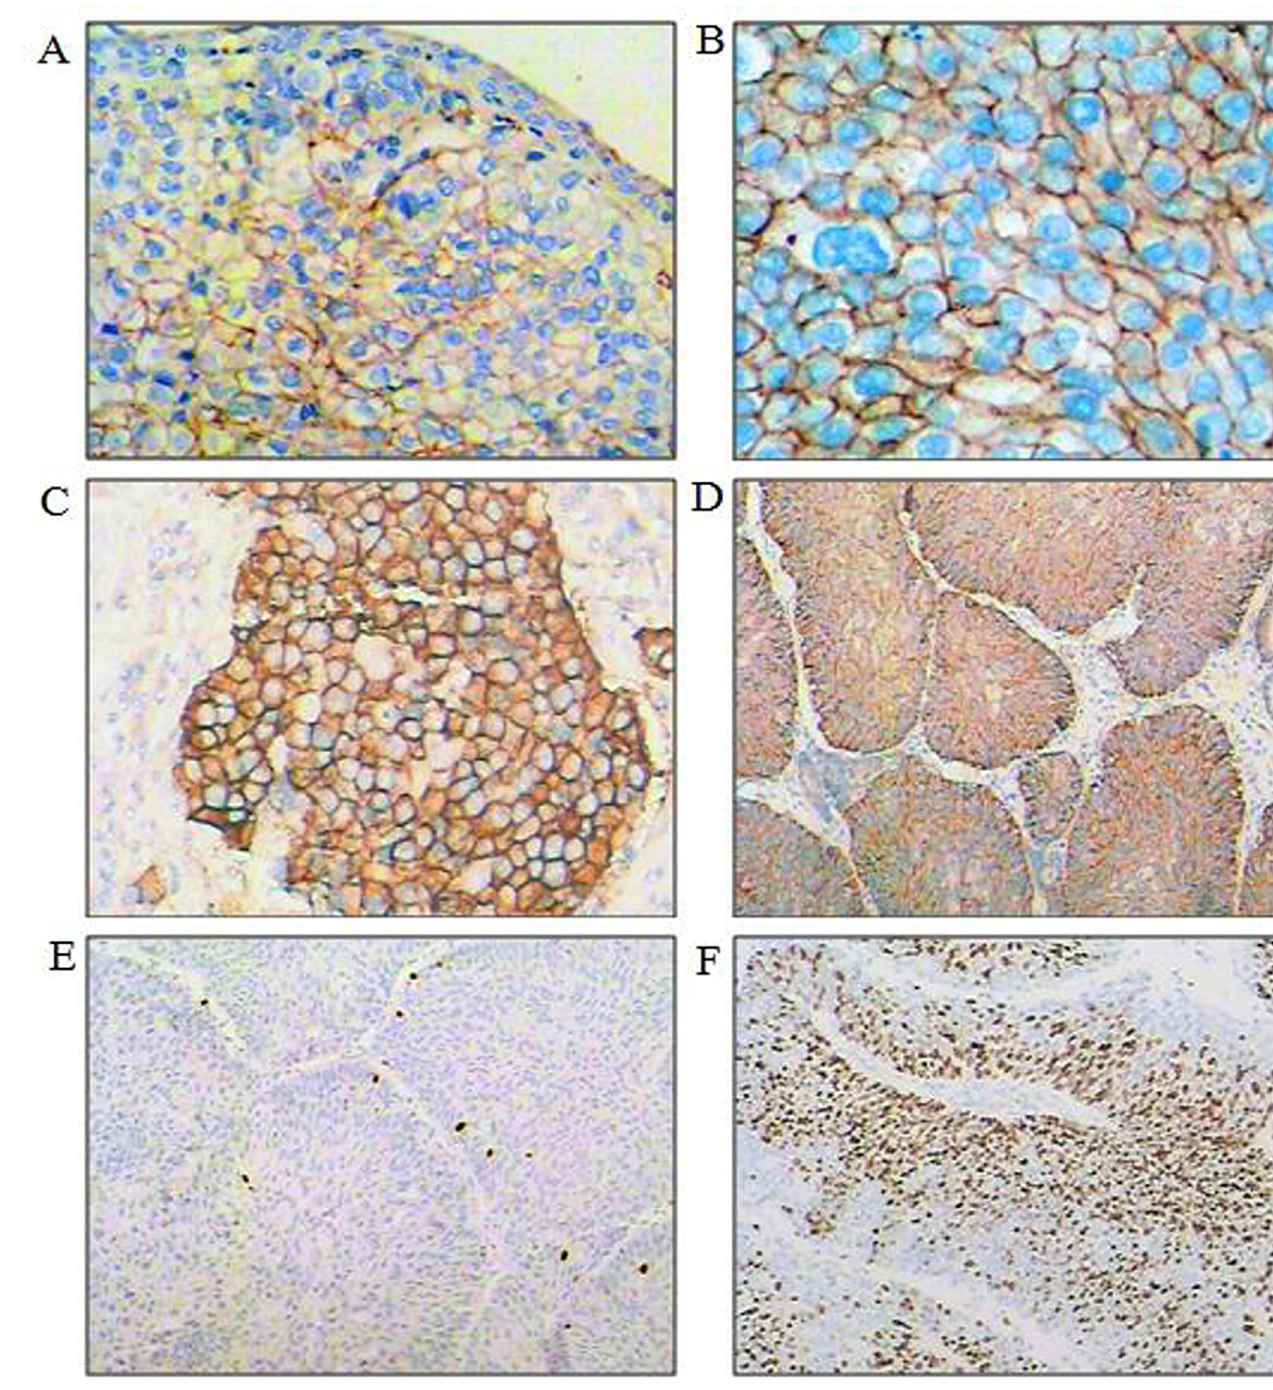
Fig 1. EGFR and Ki-67 Immunohistochemistry. (A) Relativelyweak and incompletemembranous EGFR 1+ staining(magnification × 200) in a urothelialcarcinoma(UC). (B) Moderate and mostly completemembranous EGFR 2+ staining(magnification × 400) in a UC. (C) Strong and completemembranous EGFR 3+ staining in a UC (magnification × 200). (D) Strong and completemembranous EGFR 3+ staining in a UC (magnification × 100). (E) Very low-levelKi-67 expressionin a UC with few positive cells (magnification × 100). (F) Ki-67 overexpression in a UC with more than 50% positive cells (magnification ×